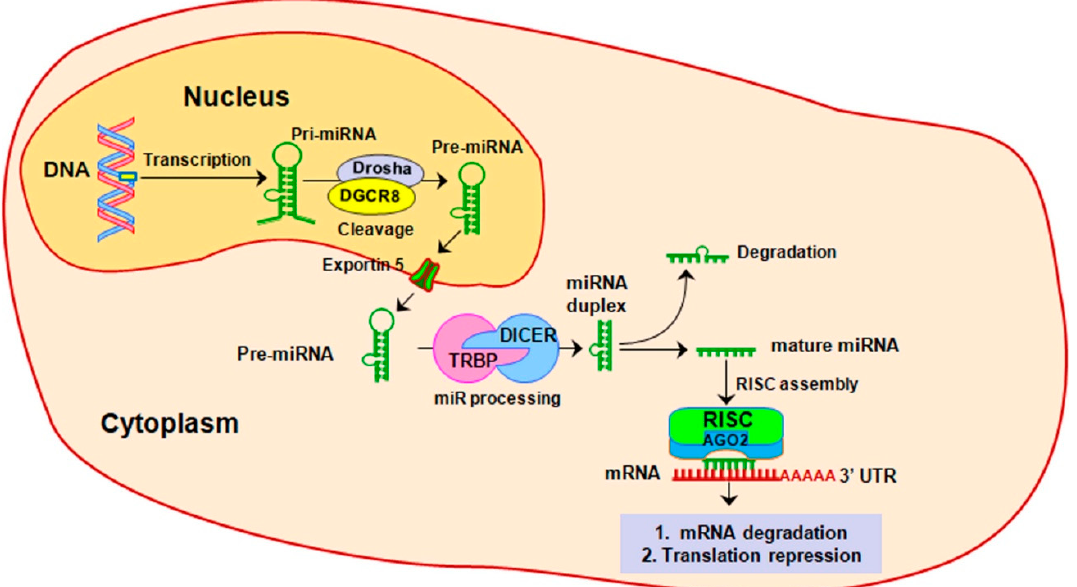
Figure 2. MiRNA biogenesis. MiRNA biogenesis starts in the nucleus with a long hairpin transcript called pri-miRNA that is further processed to a smaller transcript of 70 nucleotides. After is exported in the cytoplasm, pre-miRNA is enzymatically processed to single-strand mature miRNA of about 21–23 nucleotides. When it is incorporated in the enzymatically machinery called the RNA-induced silencing complex (RISC), mature miRNA guide the RISC to silence the specific mRNA transcripts, either by their degradation of by translation repression.